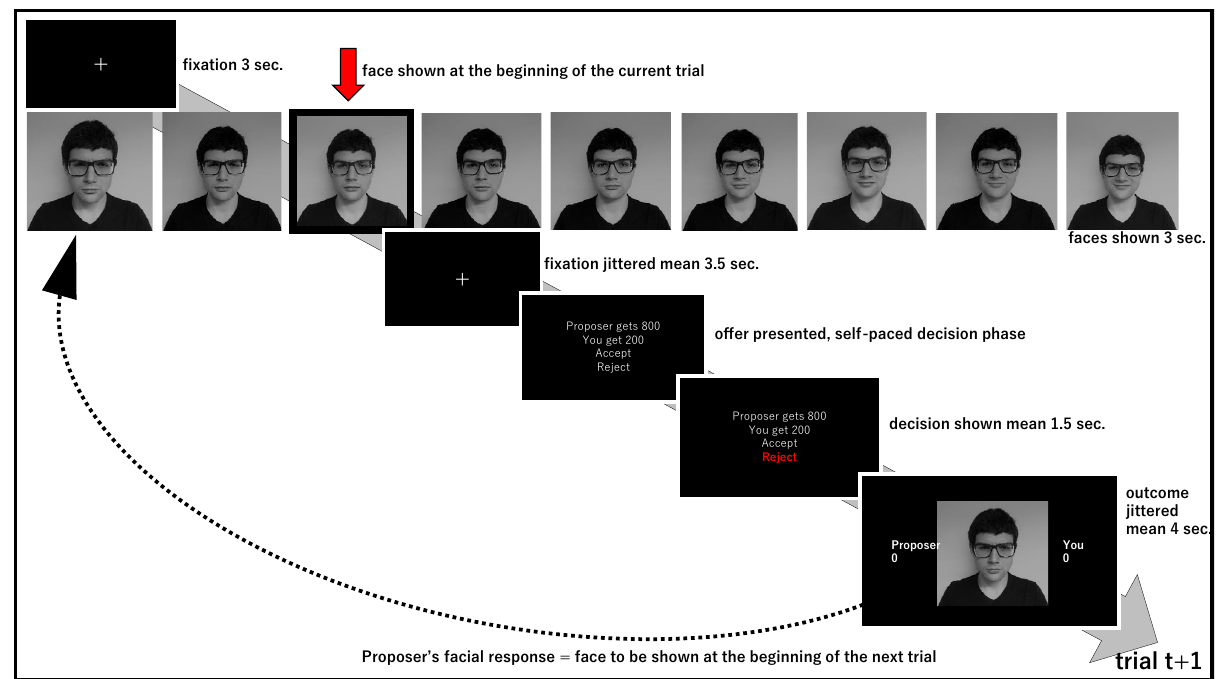
Fig. 1 Experimental timeline of the novel Ultimatum Game task. On each trial, the participant is presented with an affective face of the proposer/ confederate (i.e. the red arrow) followed by an offer. In response to participant ’ s acceptance or rejection, the proposer ’ s facial emotion may stay the same or change to a neighbouring affective state based on prede fi ned transition probabilities associated with each response type (e.g. the proposer is more likely to be happier if the offer is accepted). Similarly, based on other prede fi ned transition probabilities, the offer on trial (t + 1) may stay the same or may be revised to a neighbouring offer amount based on participant response (e.g. the offer of 200 shown in the example above for trial (t) may increase to 250 on trial (t + 1), after the participant rejected the fi rst offer). The prede fi ned transition probabilities for facial emotions and offer amounts for the novel UG task are available in Supplementary Materials.